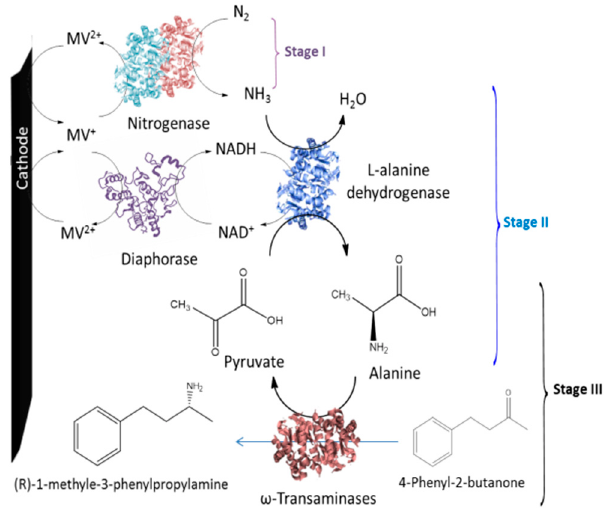
Figure 15. A schematic of bioelectrochemical asymmetric amination [52] .